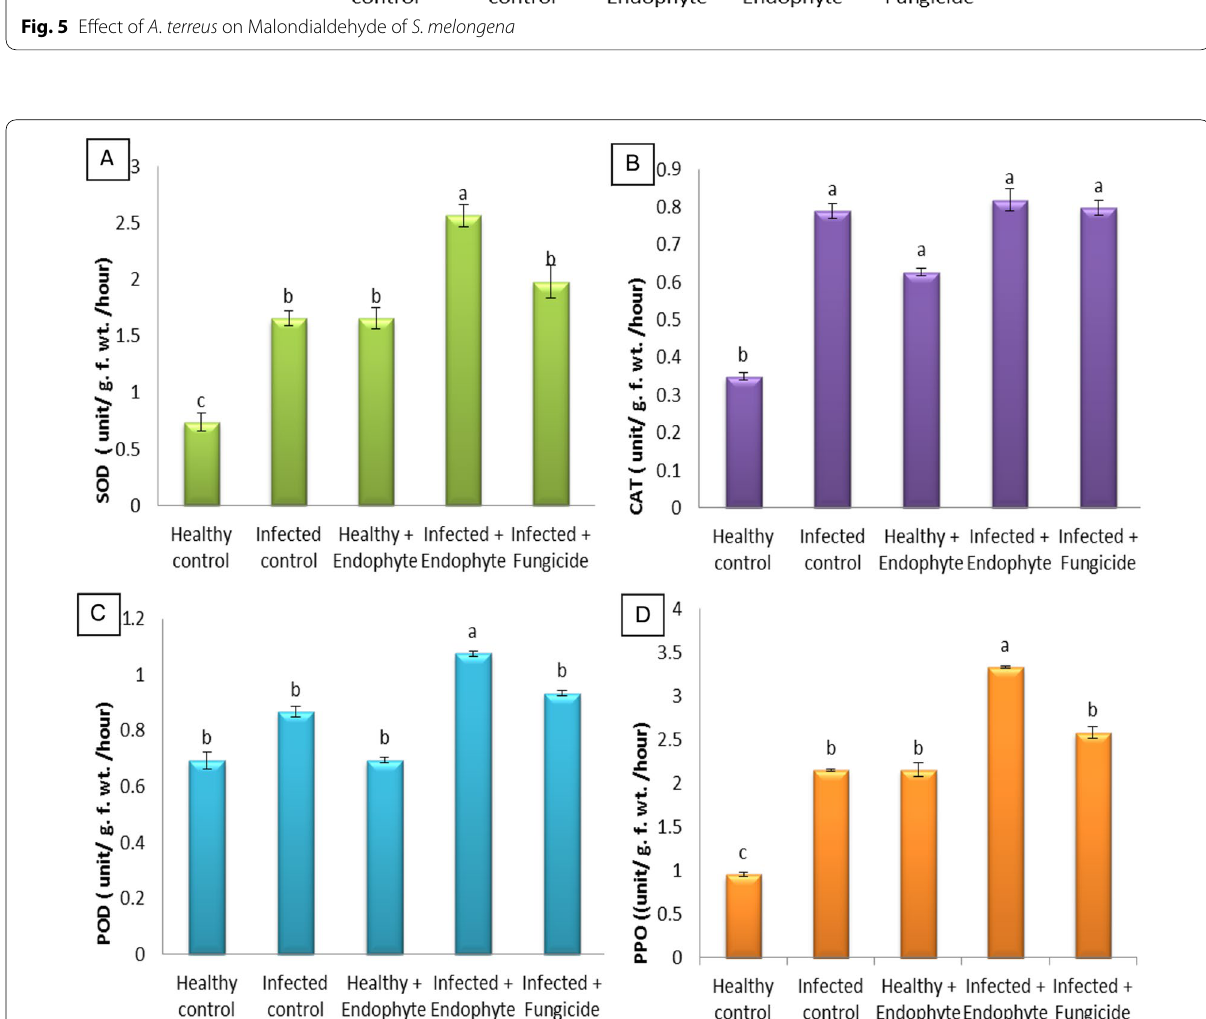
Fig. 6 Effect of A . terreus on A superoxide dismutase, B catalase, C peroxidase and D polyphenol oxidase of S. melongena . Each bar represents mean standard ±